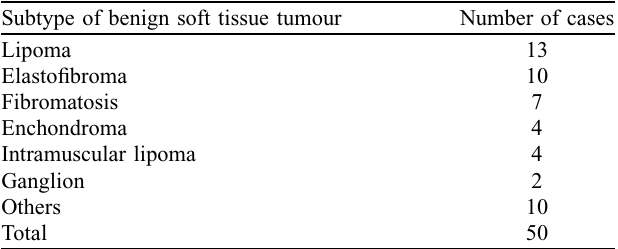
Table 4. Commonest benign soft tissue tumours of the